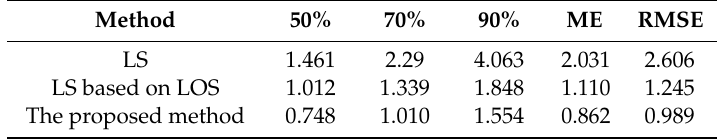
Table 2. The statistical results of positioning errors of the three algorithms /